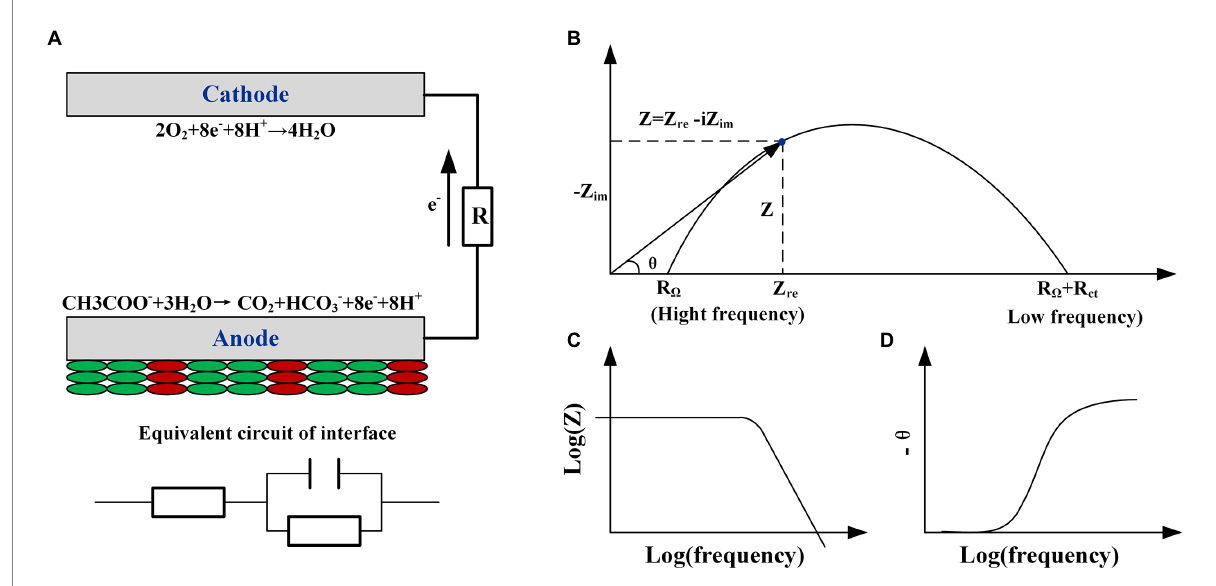
FIGURE 1 (A) The schematic of microbial fuel cell’s reaction and the equivalent circuit of the anode interface R(RC). (B) Nyquist, (C) BODE, and (D) phase angle plots of the